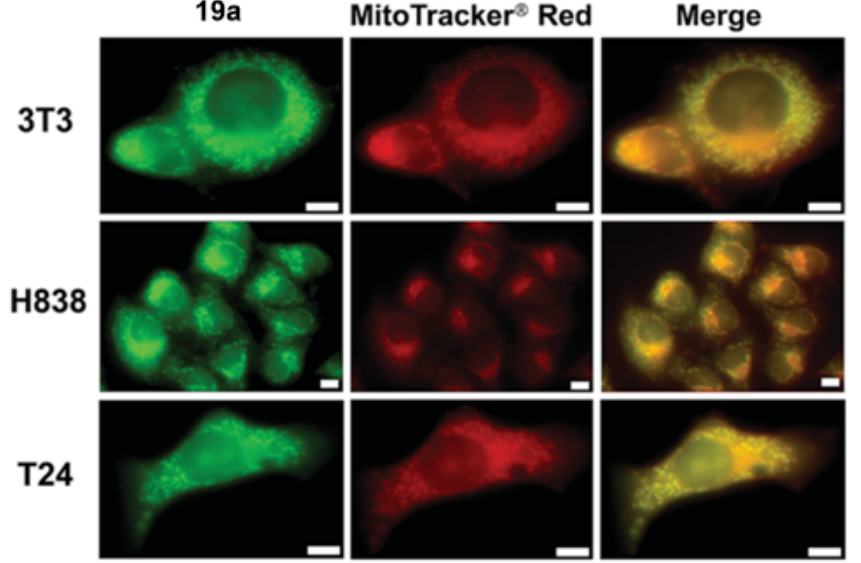
Figure 16. Confocal microscopy colocalization images of various cell lines (3T3, H838, T24 cells) of 19a and mitochondrial-specific probe MitoTracker ® Red. Column 1: 19a fluorescence under a GFP channel, column 2: MitoTracker ® Red fluorescence under an RFP channel, and column 3: merged images. Adapted from [47].